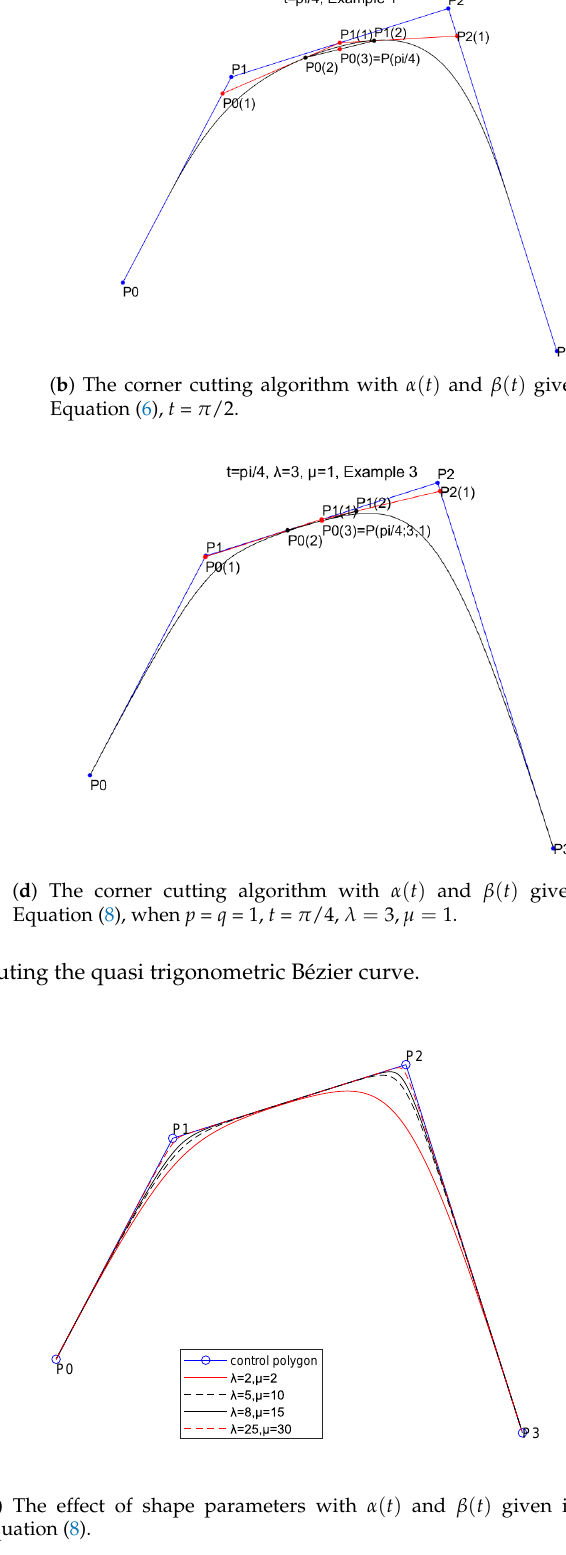
Figure 5. The effect of shape parameters on the generalized quasi cubic trigonometric Bézier curves, when λ = 2, µ = 2; λ = 5, µ = 10; λ = 8, µ = 15; λ = 25, µ =